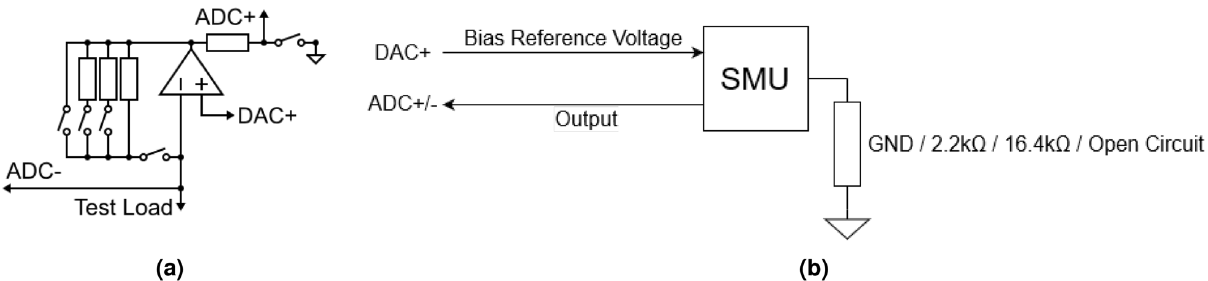
Figure 4. ( a ) functional schematic of the channel extracted from Fig. 2a. ( b ) high-level schematic indicating the loading configuration used in the